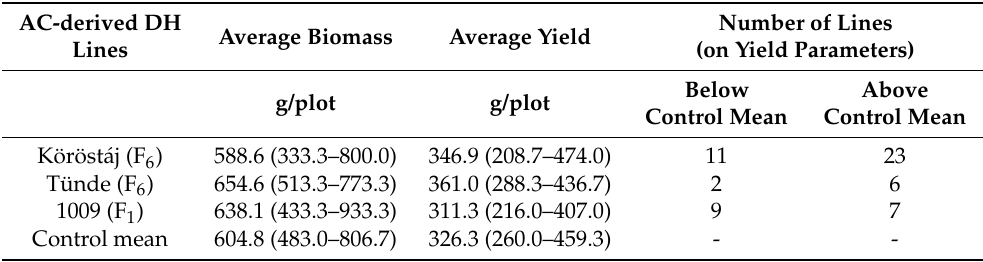
Table 6. Agronomic traits of DH lines (DH 1 generation) in micro-scale temperate rice field experiment